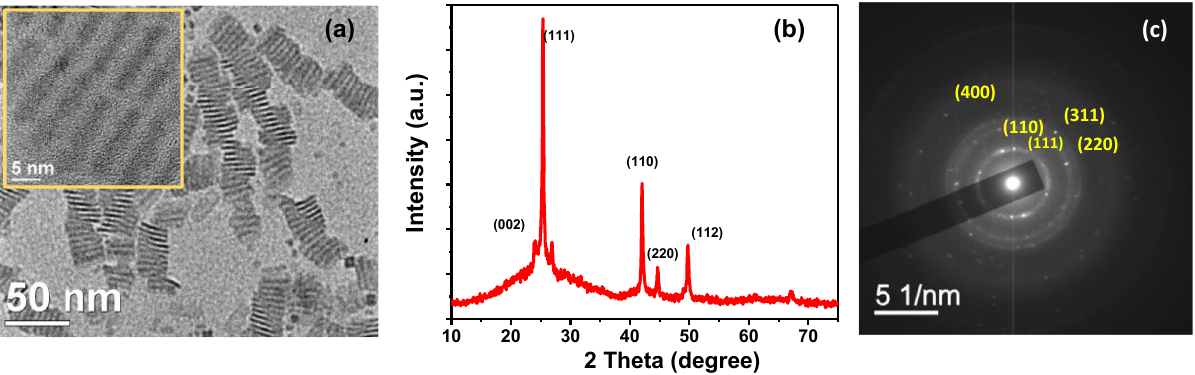
Figure 1: Structural characterization of Cu-doped NPLS; (a) TEM image of Cu-doped CdSe NPLs (inset: HRTEM image), (b) XRD pattern, and (c) SAED image of Cu-doped CdSe